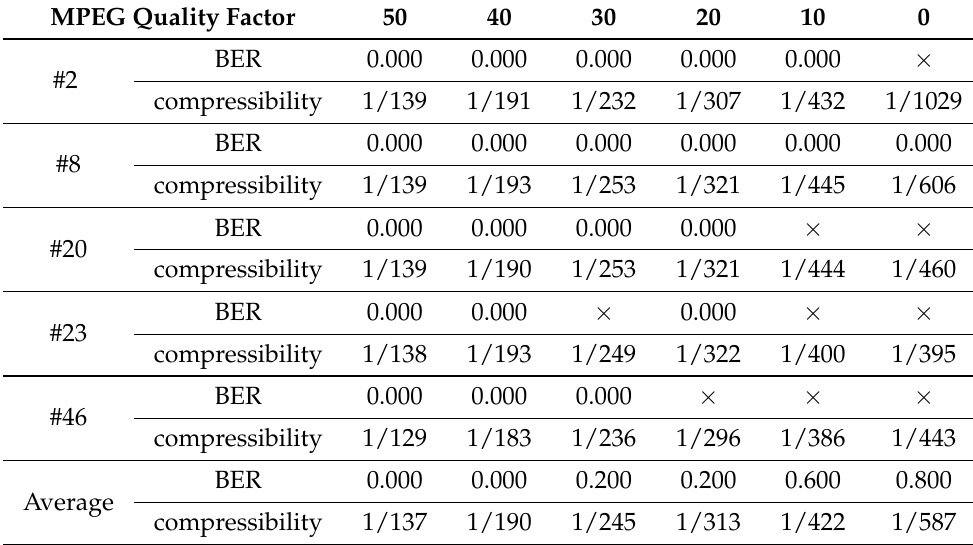
Table 4. Robustness results for the benchmark Set-4 with the watermark strength α = 0.4 (PSNR 44.03 dB, SSIM 0.9945, α =